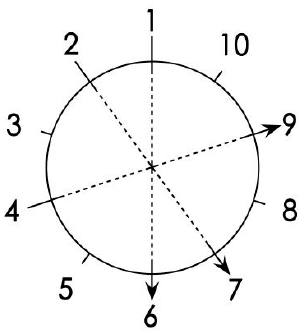
Figure 5. Internal testing path of the impedance meter. The impedance meter results show that the relative resistance value in the middle of the wood column was obviously lower than that of the surrounding material; this difference can be used to clearly distinguish the specific boundary of the internal dam- age. Take the distance (200 mm) from wood column C5 to the column foundation as an example (Figure 6).